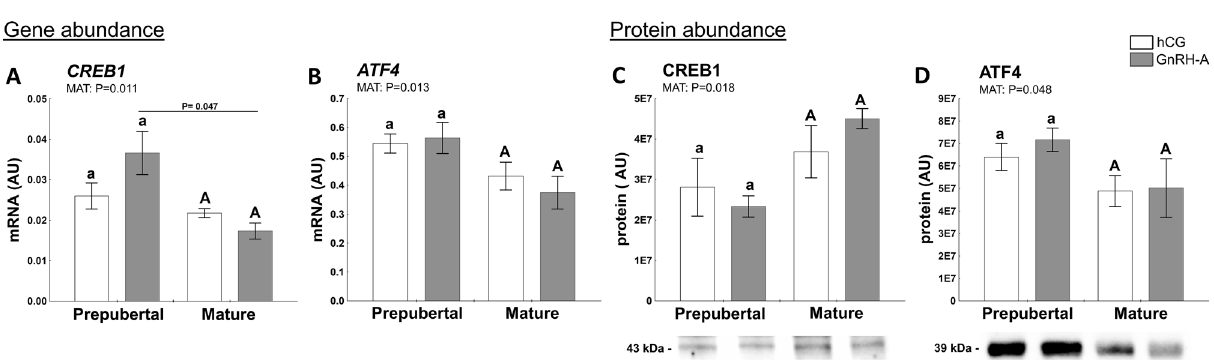
Figure 5. Hormones (hCG and GnRH-A; HORMONE) and sexual maturity status (prepuberty or maturity; MAT) affect abundance of transcription factors governing in ovarian follicles of prepubertal and mature gilts. The abundance of CREB1 ( A , C ) and ATF4 ( B , D ) in prepubertal and mature gilts was evaluated. Gene expression was normalized to the geometric mean of ACTB and GAPDH (AU), identified as the best reference genes by NormFinder algorithm. Protein levels were normalized to total protein content (AU) using TGX Stain-Free gel technology ( C , D ). Uncropped blots are presented in Supplementary Fig. 3C online. Data were analyzed using two-way ANOVA with Sidak multiple comparison (mRNA) or Tukey post-hoc (protein) tests and are presented as mean ± SEM (n = 5–6 per group). Means with different superscripts differ significantly (small letters—prepubertal gilts, capital letters—mature gilts; P < 0.05). Line with a P value denote significant differences between prepubertal and mature gilts. AU—arbitrary